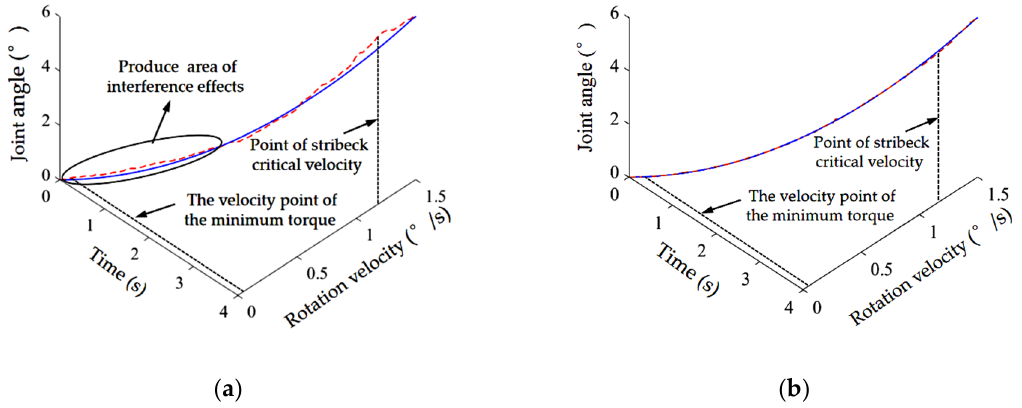
Figure 12. Comparison of whole identification method and piecewise identification method. ( a ) Whole identification method, ( b ) Piecewise identification method.